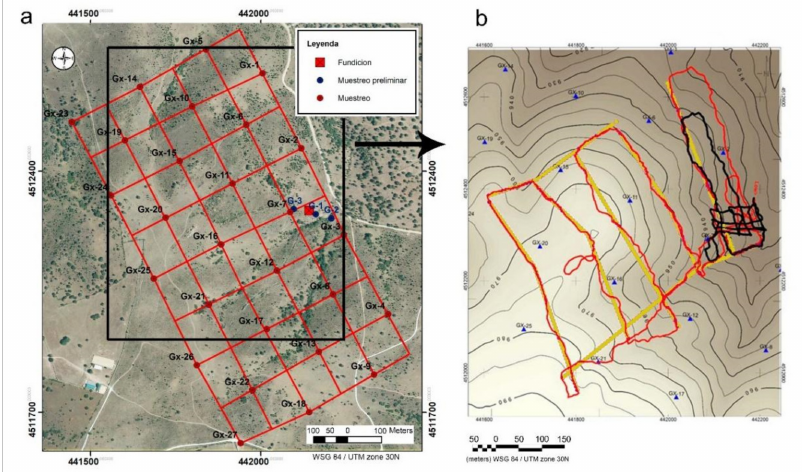
Figure 2. ( a ) Geochemical sampling design. ( b ) Topographic map of the study area with the position of the data obtained with the CGM in Low mode (red) and in "high" mode (black line). The yellow points show the position where the tomographic inversions of the apparent resistivities have been made. The blue triangles correspond to the position of the geochemical